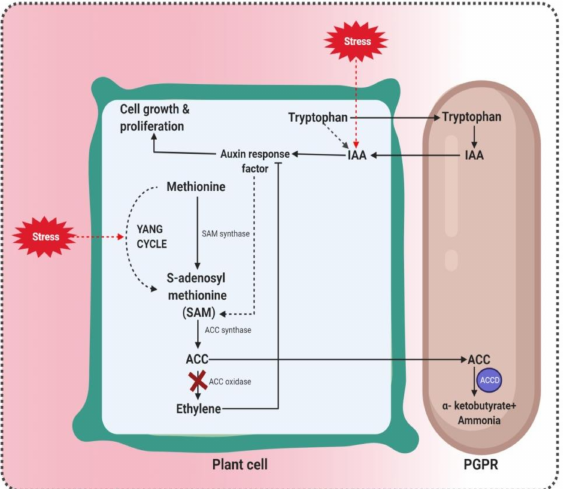
Figure 3. Salt stress increases ethylene production, thereby reducing plant growth. ACC deaminase of PGPR inhibits ethylene biosynthesis under salt stress. PGPR harboring ACC deaminase reduce ethylene production by converting ACC into α -ketobutyrate and ammonia. Adapted from del Carmen Orozco–Mosqueda et al.